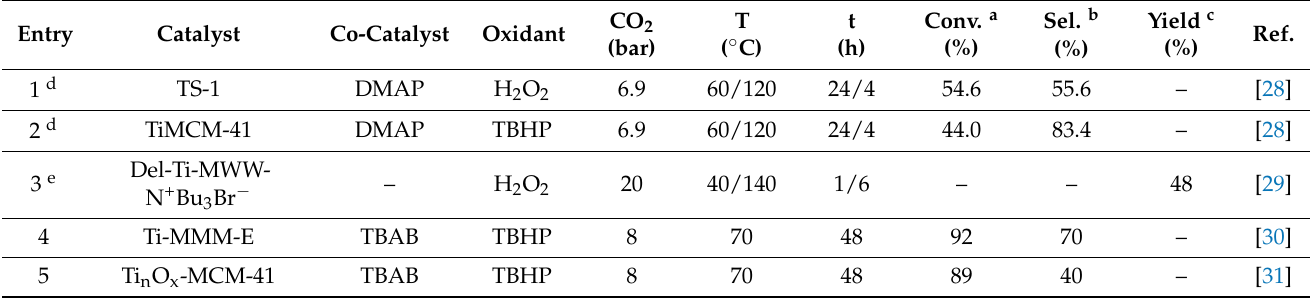
Table 2. The direct oxidative carboxylation of olefins catalyzed by the heterogeneous catalytic